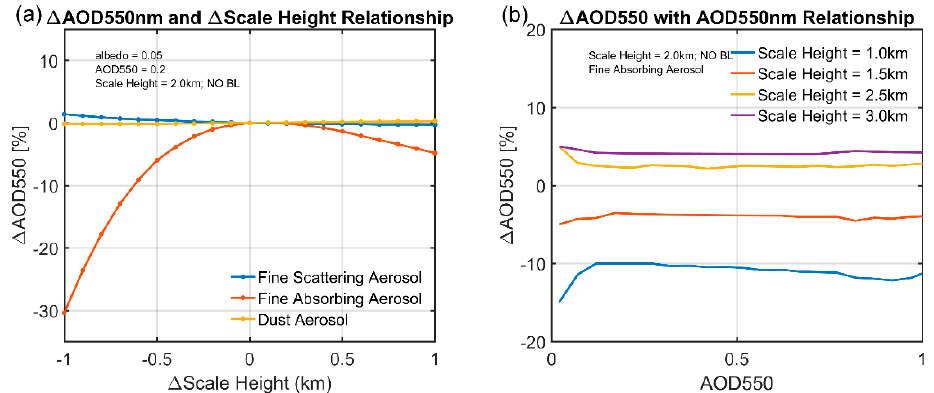
Figure 3. ( a ) The relative errors of AOD (Aerosol Optical Depth) 550nm with the errors of scale height for three different aerosol models. ( b ) The change in AOD relative error with AOD value. The true scale height is assumed to be 2 km.